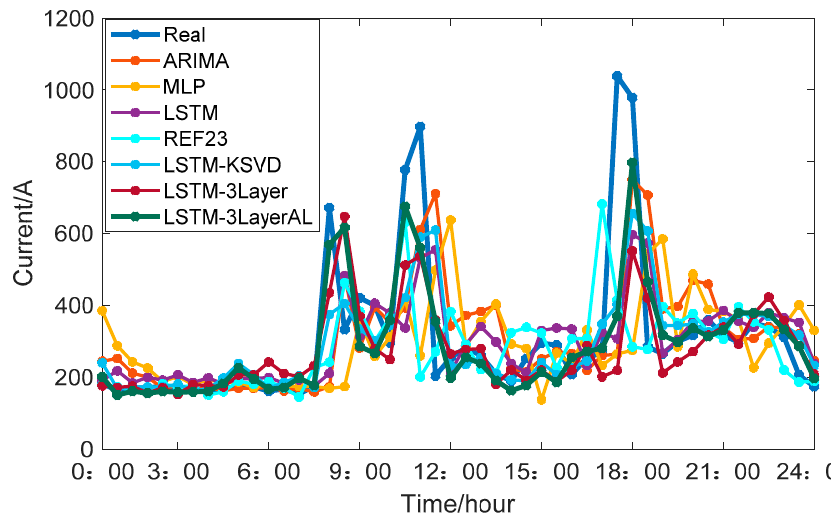
Figure 9. Forecasting results throughout a day for the leading scenarios using data from AMPds dataset.